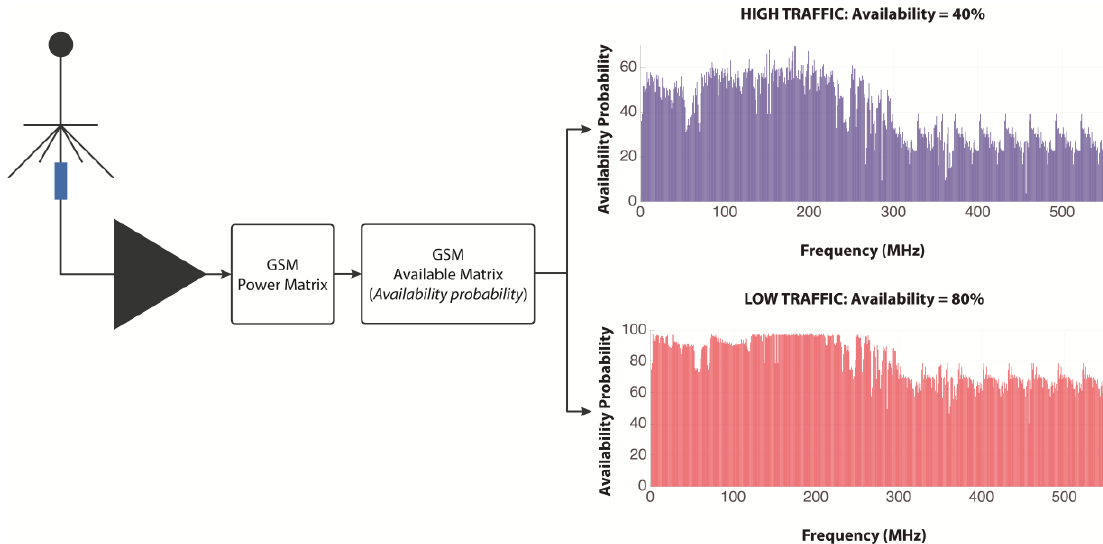
Figure 2. Experimental configuration for measuring spectral occupancy.